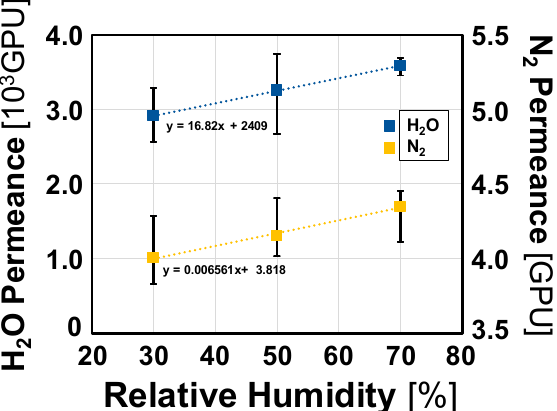
Figure 6. Permeance of H 2 O and N 2 as a function of relative humidity.